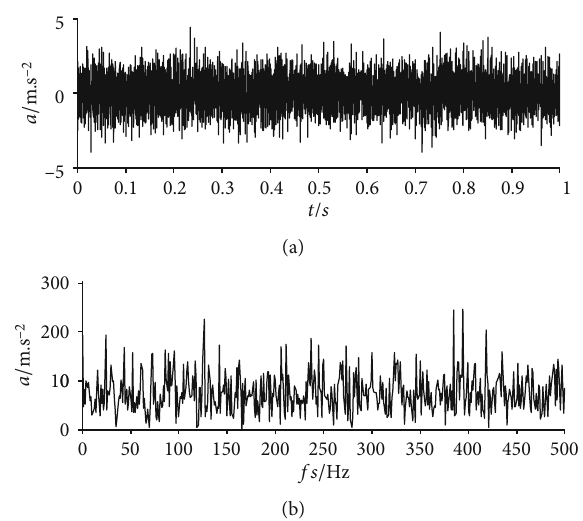
Figure 1: Simulated signal and its frequency spectrum. (a) The waveform of the simulated signal. (b) The frequency spectrum of the simulated signal.